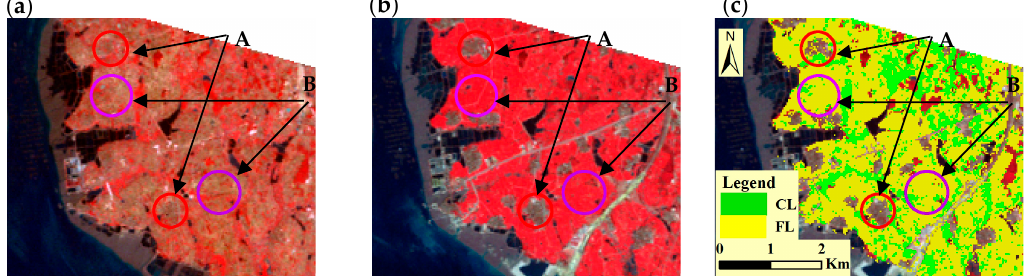
Figure 6. Comparison of original images with undistinguishable fallow land and built-up land, and an arable land map: ( a ) original image in 2003; ( b ) original image in 2007; ( c ) arable land map extracted from feature-based approach of decision tree classification in 2003. Notes: A and B represent built-up land and fallow land; CL and FL stand for cropland and fallow land.